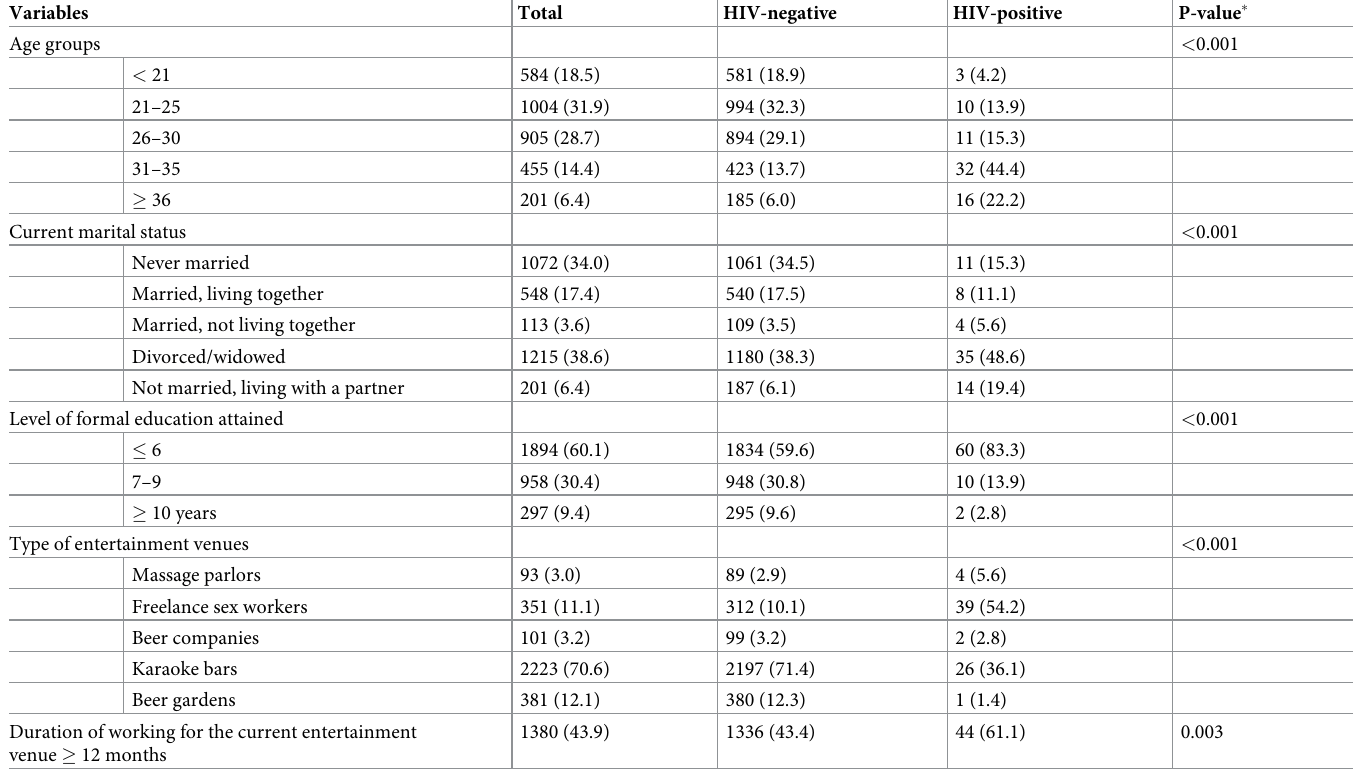
Table 1. Socio-demographic characteristics of HIV-positive and HIV-negative FEWs ( n =